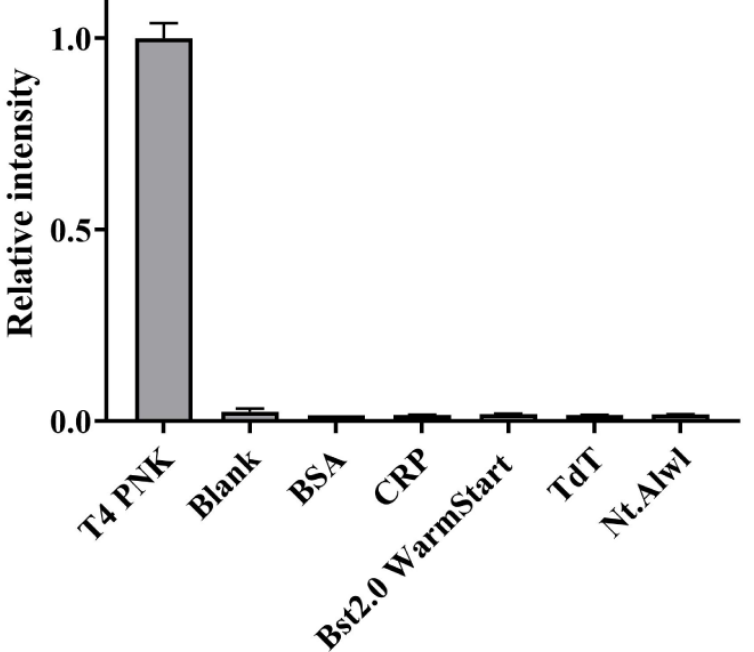
Figure 4. The selectivity of the label-free detection of T4 PNK activity based on the ligation-triggered transcription. The fluorescence intensities at 650 nm were all normalized to 1. The error bars represent the standard deviation (SD) across three repetitive experiments over the blank response.